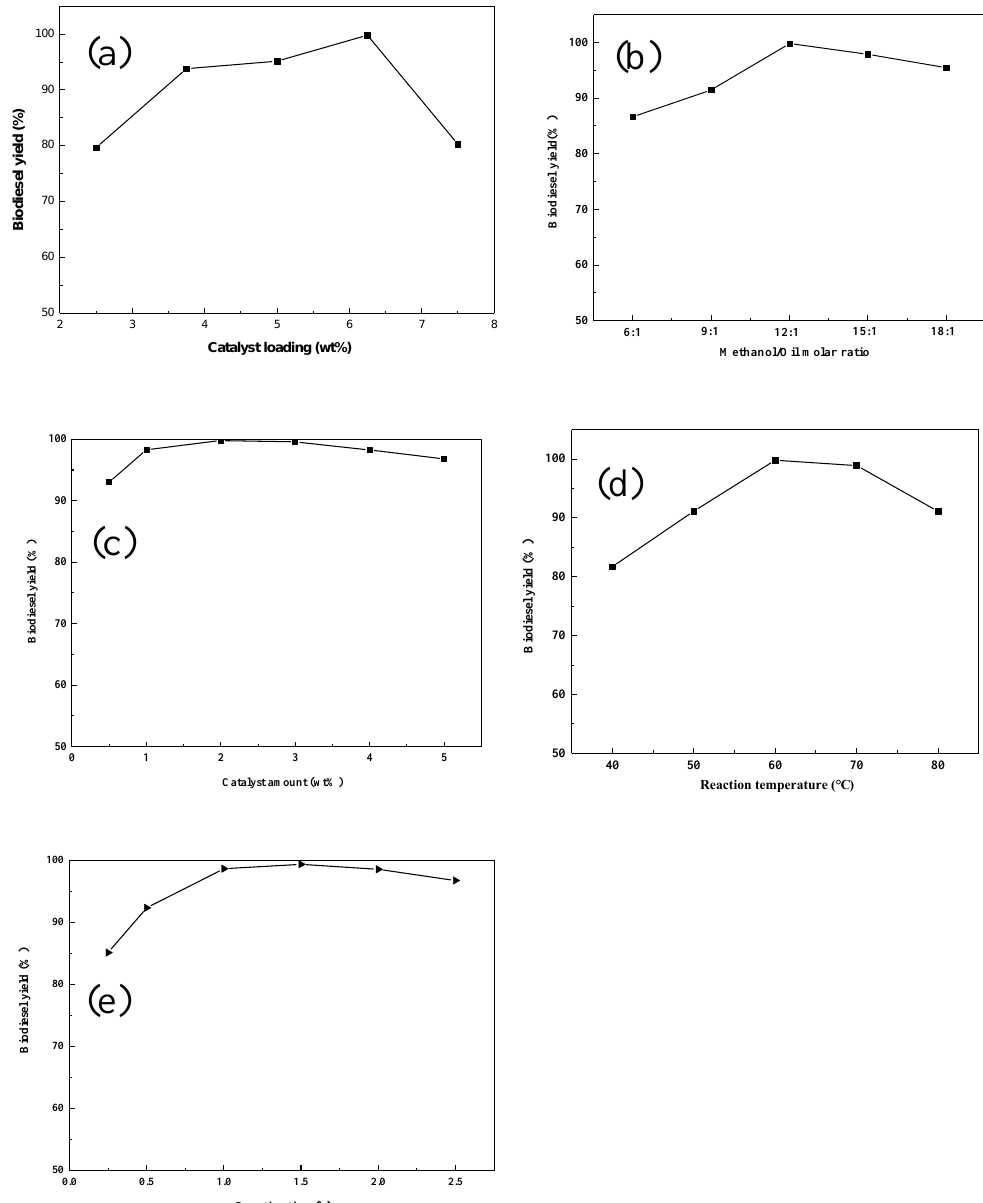
Figure 7. E ff ects of the reaction conditions on the biodiesel yield. ( a ) E ff ect of the loading ratio of K + ; Figure 7. Effects of the reaction conditions on the biodiesel yield. ( a ) Effect of the loading ratio of K + ; ( b ) E ff ect of the molar ratio of methanol / oil; ( c ) E ff ect of the catalyst amount used; ( d ) E ff ect of the ( b ) Effect of the molar ratio of methanol/oil; ( c ) Effect of the catalyst amount used; ( d ) Effect of the reaction temperature; ( e ) E ff ect of the reaction time. A typical reaction condition is 12:1 molar ratio of reaction temperature; ( e ) Effect of the reaction time. methanol / oil, 6.25 wt% load ratio of K + / HT, and 60 ◦ C for 1